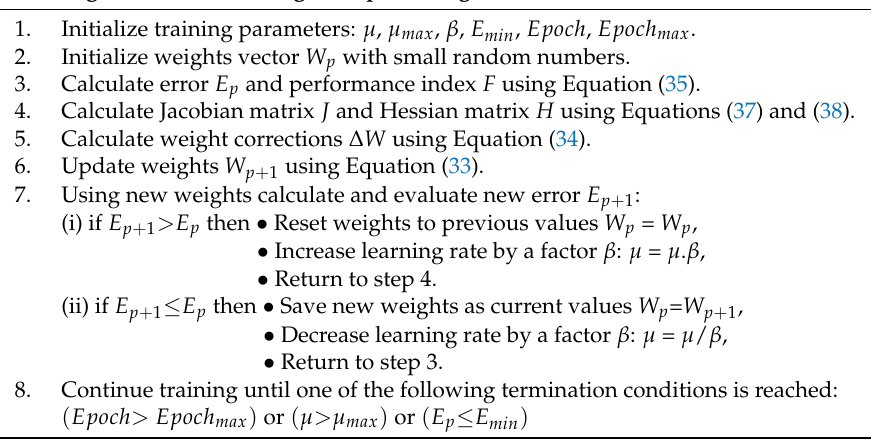
Algorithm 1: Levenberg–Marquardt Algorithm